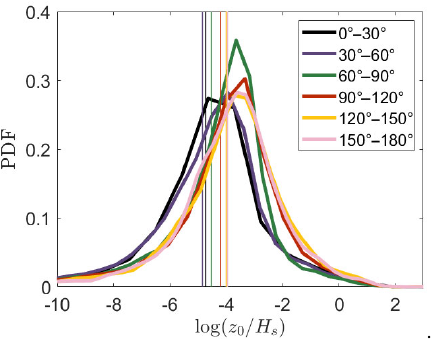
Figure 6. Probability density function of the dimensionless rough- ness length parameter for six different alignment groups, from aligned to opposed cases for the combined ASIT and FINO1 data set. The vertical lines represent the mean value of the different alignment